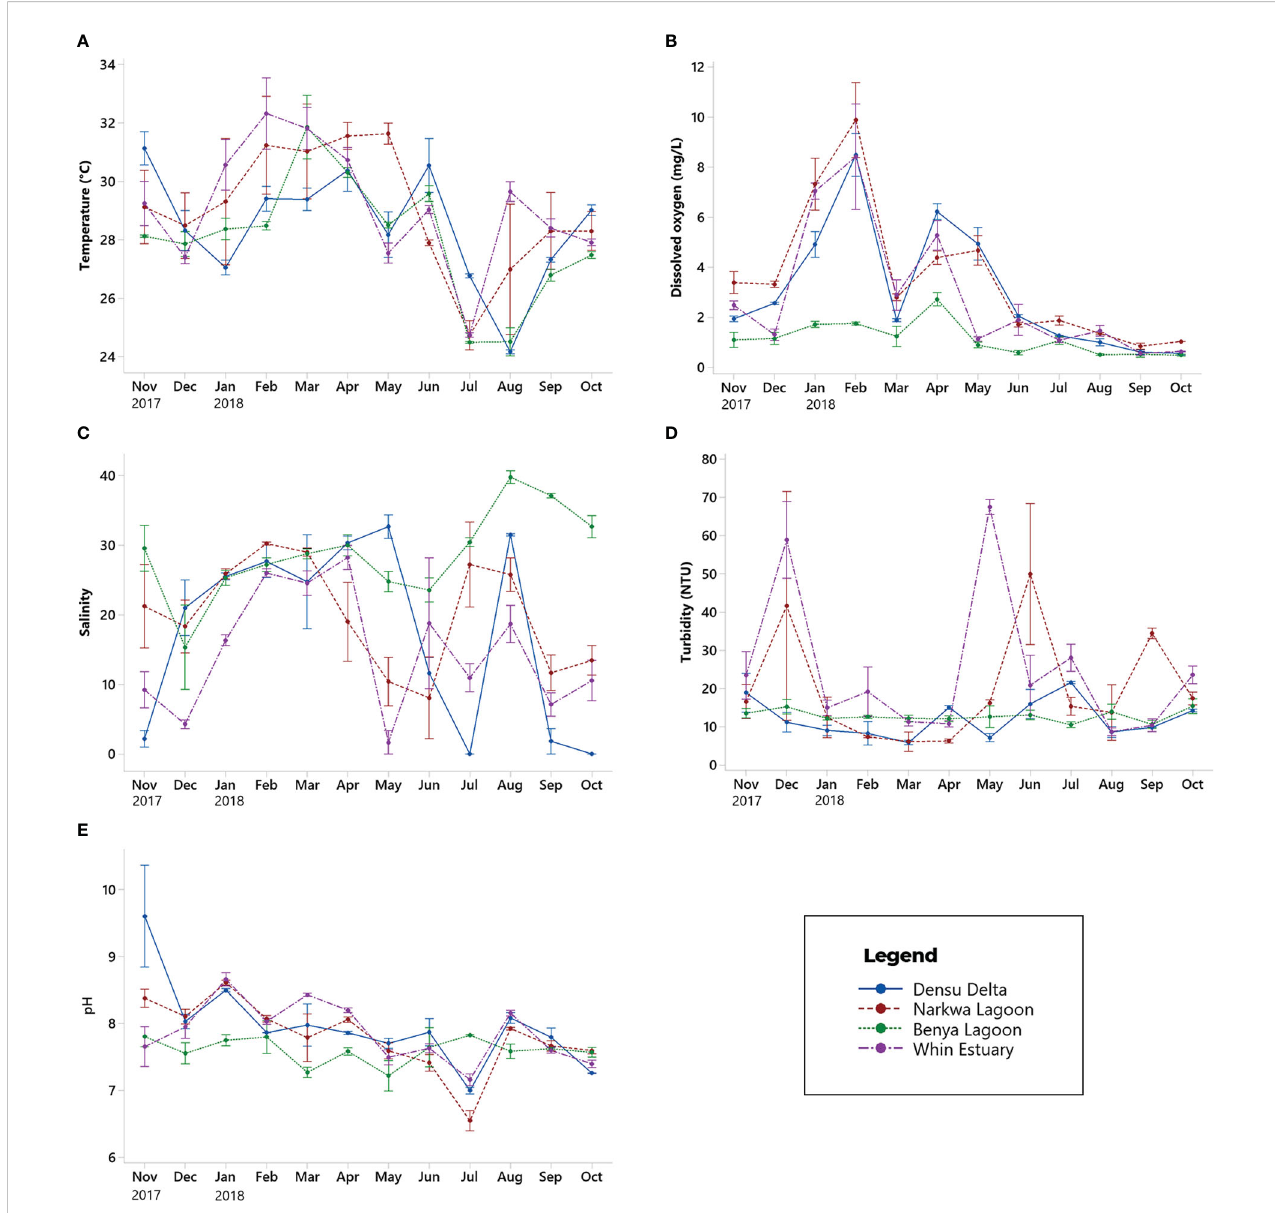
FIGURE 7 Monthly mean (± SE) concentrations of physico-chemical estuarine parameters - (A) Temperature, (B) Dissolved oxygen, (C) Salinity, (D) Turbidity, and (E) pH - in the Densu Delta, Narkwa Lagoon, Benya Lagoon and Whin Estuary from November 2017 to October 2018. Data were pooled for all stations in each water